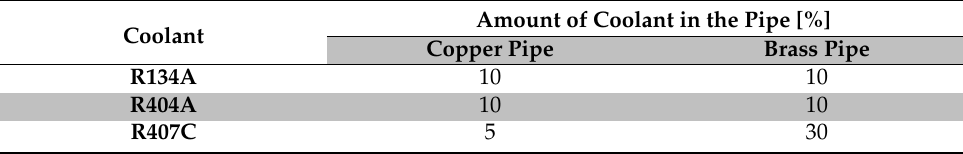
Table 1. Values adopted in the simulation of the content of working